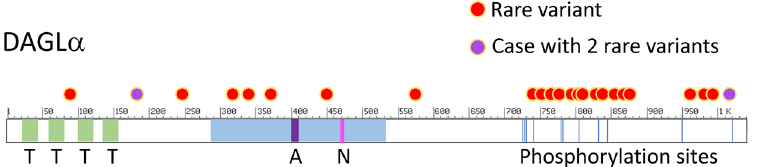
Fig 2. Mapping of rare variants to diacylglycerol lipase alpha. The location of rare coding variants relative to domainsof the enzyme and regulatoryphosphorylation sites are indicated, based on NCBI Reference Sequence: NP_006124.1. Red dot: rare variant; purpledots: two variants present in one subject; T (light green shading): transmembrane domain;light blue shading: lipasedomain; A (purpleshading): Active site; N (magenta shading):Nucleophilic elbow; blue vertical lines: phosphorylation sites.